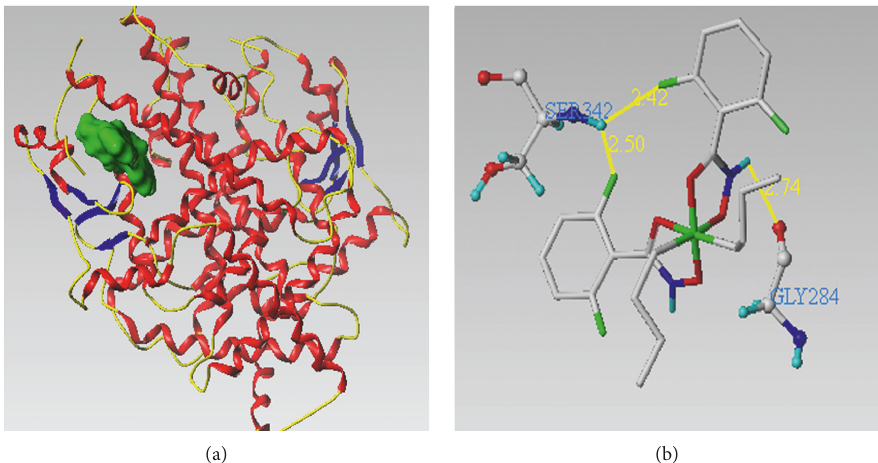
Figure 8: The docking results of DBDF2,6T to hPPAR c protein: (a) the generated pocket of hPPAR c protein; (b) hydrogen bond graph of DBDF2,6T to the interacted residues of the hPPAR c protein. The yellow lines in the picture represent the hydrogen bond.